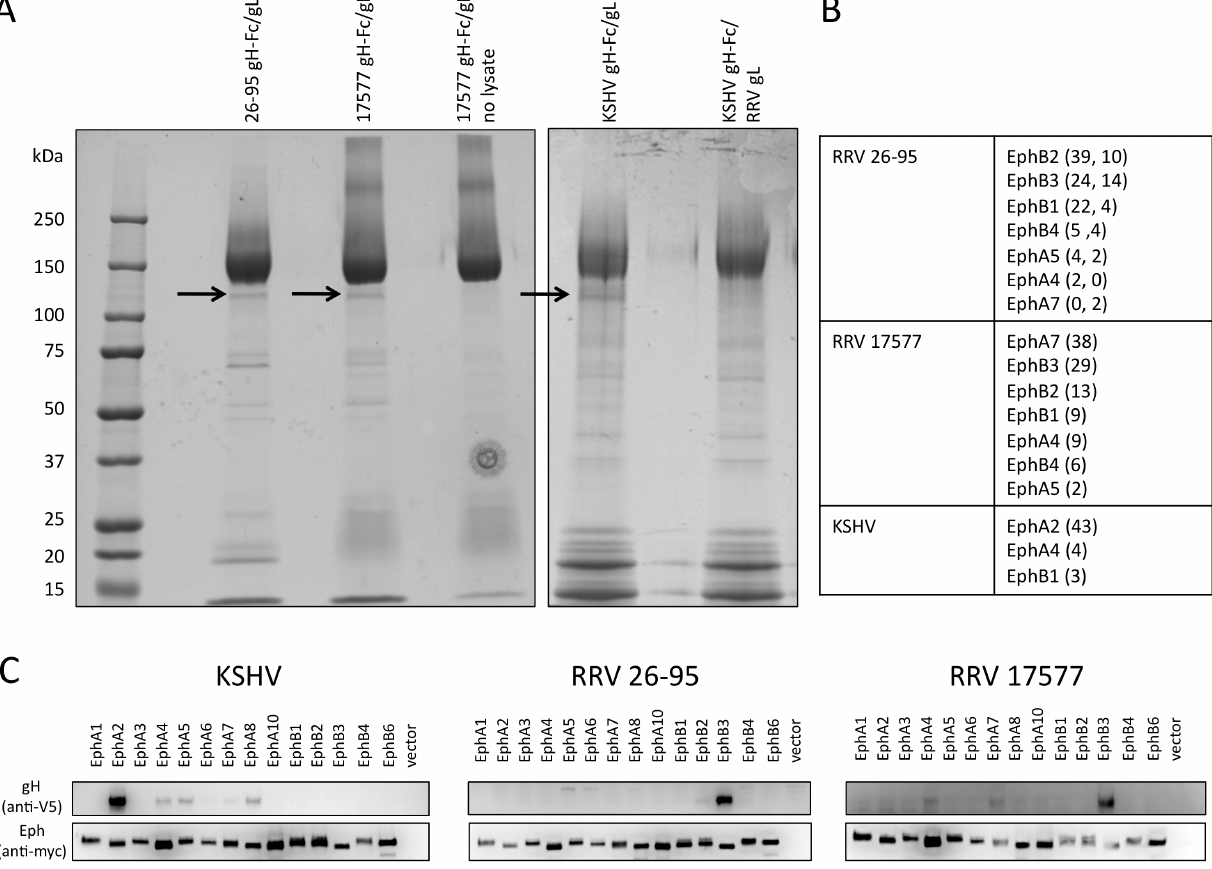
Figure 1. Identification of cellular interaction partners of RRV gH/gL. ( A ) Purification of proteins interacting with the ectodomains of RRV 26- 95, RRV 17577 and KSHV. Lysates of 293T cells were incubated with gH-Fc/gL (Strep epitope-tagged) complexes from RRV 26-95 or 17577 pre- coupled to Streptactin beads. After elution with desthiobiotin, the eluate was re-precipitated with Protein A sepharose, washed, and subjected to gel electrophoresis followed by colloidal coomassie staining. Arrows indicate Eph-containing bands. ( B ) Summary of proteins identified in the indicated band with the respective gH/gL complexes. The numbers of peptides identified for each protein in one sample are given in brackets. Where more than one number is given, several samples were analyzed and the first number is from the first sample, the second from the second sample. ( C ) Pairwise immunoprecipitation of individual Eph proteins with gH/gL of KSHV, RRV 26-95 and RRV 17577. Full length Eph proteins (myc epitope- tagged) were recombinantly expressed in 293T cells. The lysates were normalized for equal expression with the lysate of non-transfected 293T cells. The recombinant Eph proteins were immobilized with myc antibody on Protein G beads in a first round of immunoprecipitation. The immobilized proteins were then incubated with equal amounts of lysates from 293T cells transfected with expression constructs for the respective gH (V5 epitope- tagged)/gL complexes, followed by washing and Western Blot analysis.